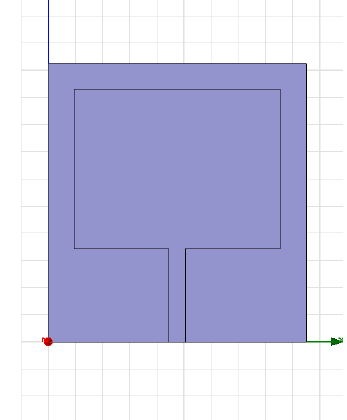
Fig. 2. Simulated structure of